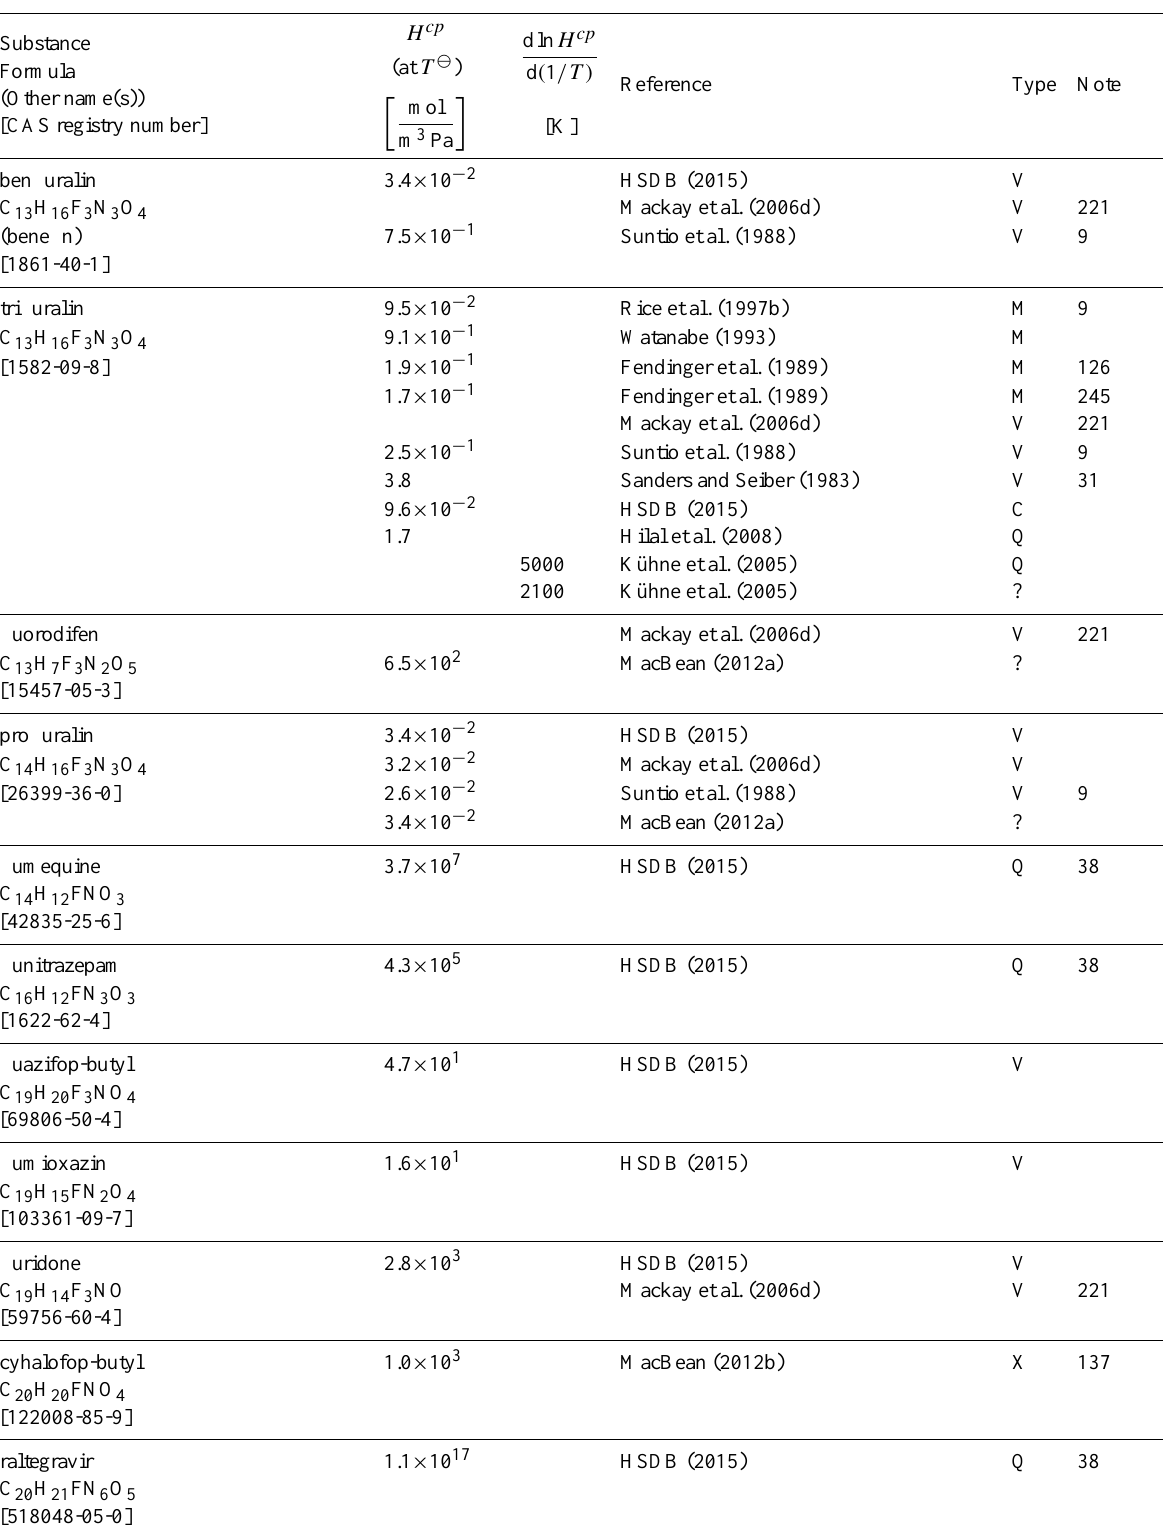
Table 6: Henry’s law constants for water as solvent